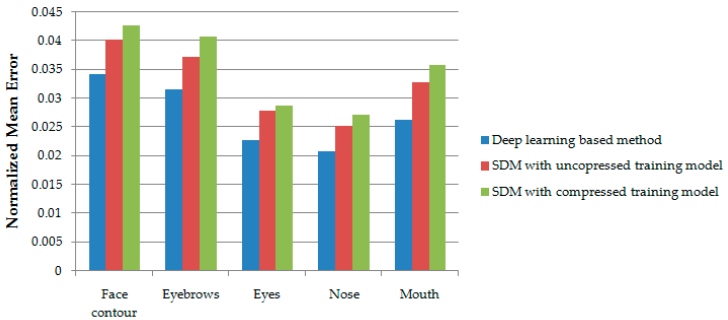
Figure 9. Normalized mean errors of our compressed training model SDM compared with the uncompressed training model SDM [6] and deep learning based method [22] on the 300 W test set [12].